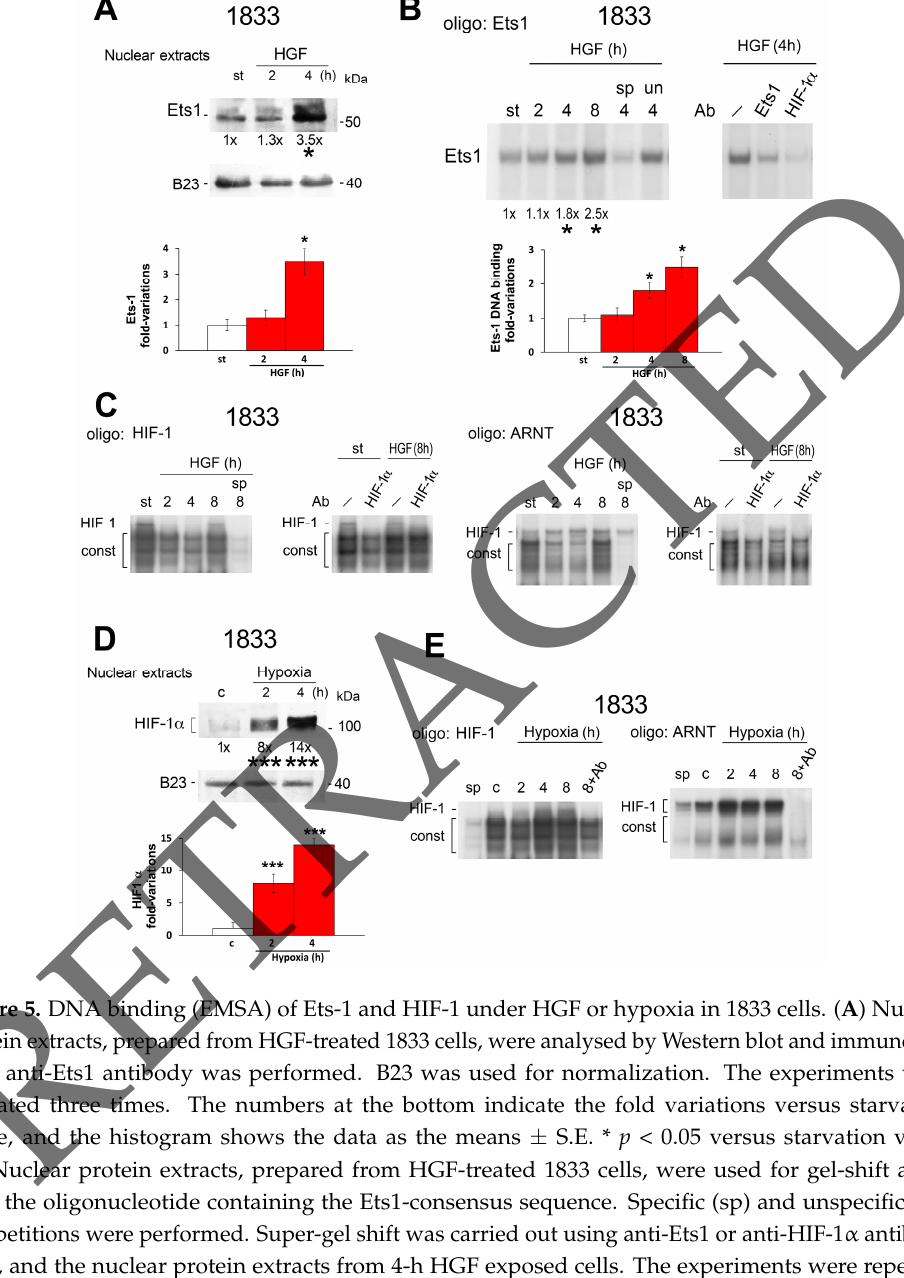
Figure 5. DNA binding (EMSA) of Ets-1 and HIF-1 under HGF or hypoxia in 1833 cells. ( A ) Nuclear protein extracts, prepared from HGF-treated 1833 cells, were analysed by Western blot and immunoblot with anti-Ets1 antibody was performed. B23 was used for normalization. The experiments were repeated three times. The numbers at the bottom indicate the fold variations versus starvation value, and the histogram shows the data as the means ± S.E. * p < 0.05 versus starvation value. ( B ) Nuclear protein extracts, prepared from HGF-treated 1833 cells, were used for gel-shift assay with the oligonucleotide containing the Ets1-consensus sequence. Specific (sp) and unspecific (un) competitions were performed. Super-gel shift was carried out using anti-Ets1 or anti-HIF-1 α antibody (Ab), and the nuclear protein extracts from 4-h HGF exposed cells. The experiments were repeated three times. The numbers at the bottom indicate the fold variations versus starvation value, and the histogram shows the data as the means ± S.E. * p < 0.05 versus starvation value. ( C ) Nuclear protein extracts, prepared from HGF-treated 1833 cells, were used for gel-shift assay with the oligonucleotides containing the consensus sequence for HIF-1 or ARNT. Specific (sp) competition was performed. Super-gel shift was carried out using anti-HIF-1 α antibody (Ab), and the nuclear protein extracts from starved or 8-h HGF exposed cells. The experiments were repeated three times. ( D ) Nuclear protein extracts, prepared from 1833 cells exposed to hypoxia, were analysed by Western blot, and immunoblot with anti-HIF-1 α antibody was performed. B23 was used for normalization. The experiments were repeated three times. The numbers at the bottom indicate the fold variations versus control value, and the histogram shows the data as the means ± S.E. *** p < 0.001 versus control value. ( E ) Nuclear protein extracts, prepared from 1833 cells exposed to hypoxia, were used for gel-shift assay with the oligonucleotide containing the consensus sequence for HIF-1 or ARNT. Specific (sp) competition was performed; super-gel shift was carried out using anti-HIF-1 α antibody (Ab) and the nuclear protein extracts from 8-h hypoxia exposed cells. The experiments were repeated three times.